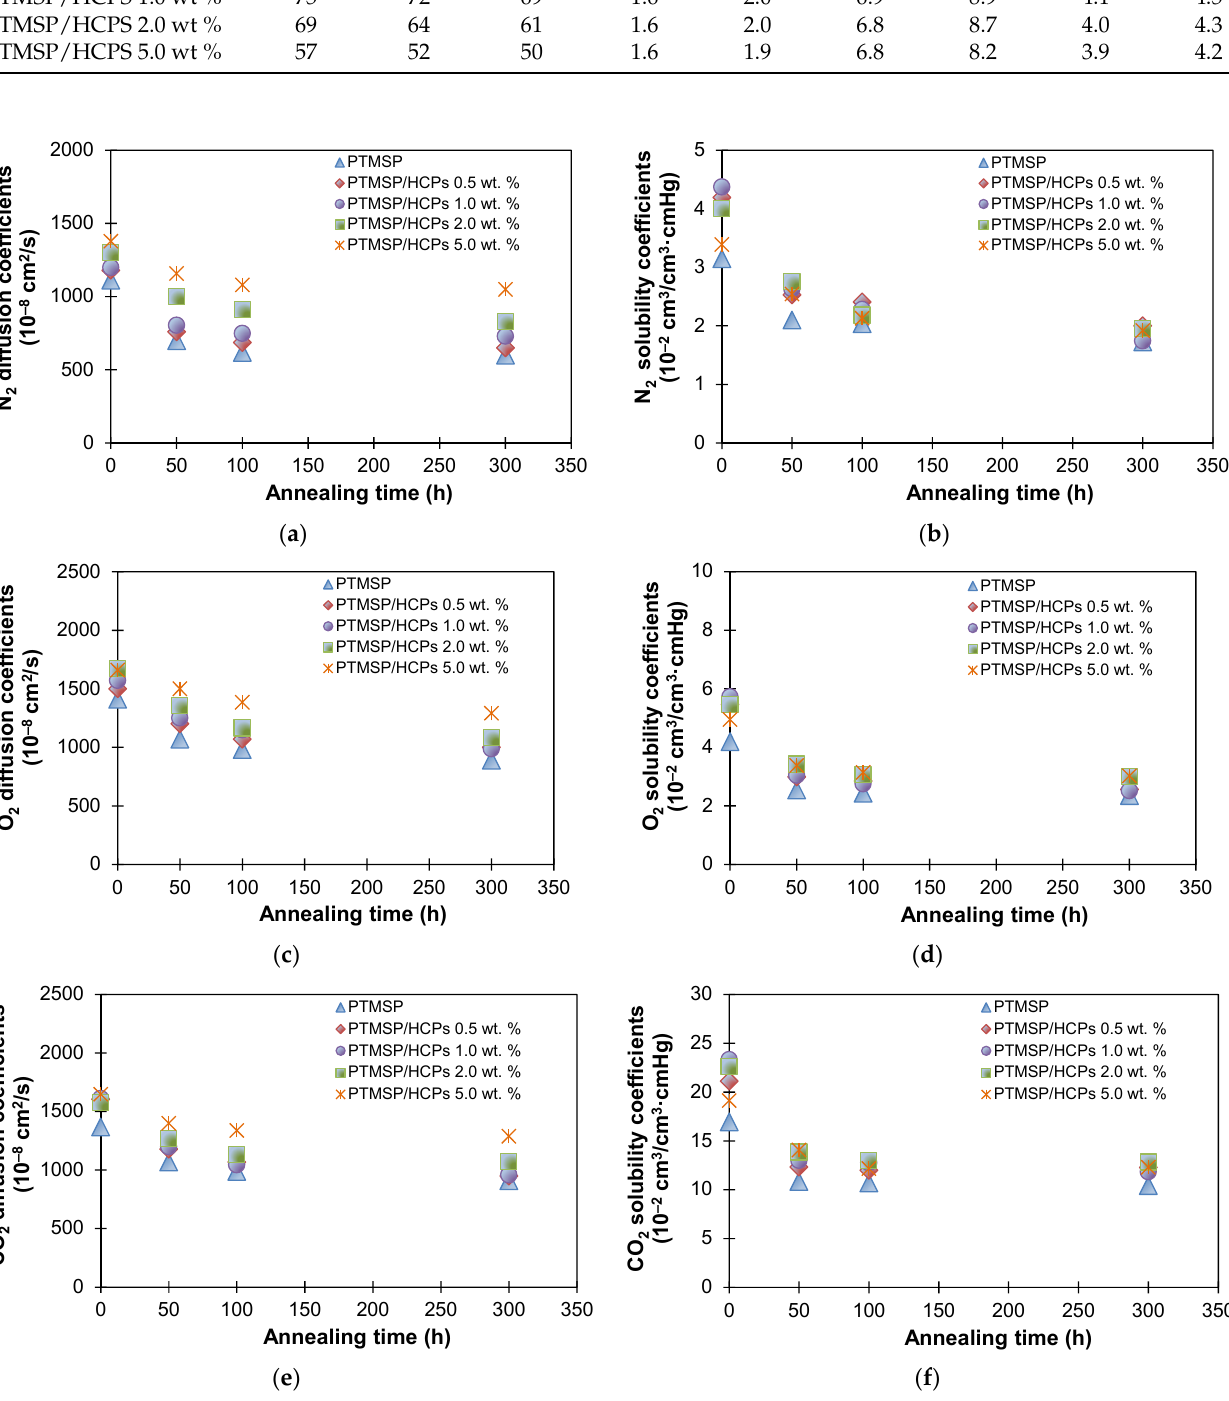
Figure 6. Diffusion coefficients and solubility coefficients of N 2 ( a , b ), O 2 ( c , d ), and CO 2 ( e , f ) in PTMSP/HCPS membranes containing 0, 0.5, 1.0, 2.0, and 5.0 wt % of HCPS plotted against the time of annealing at 100 °C.